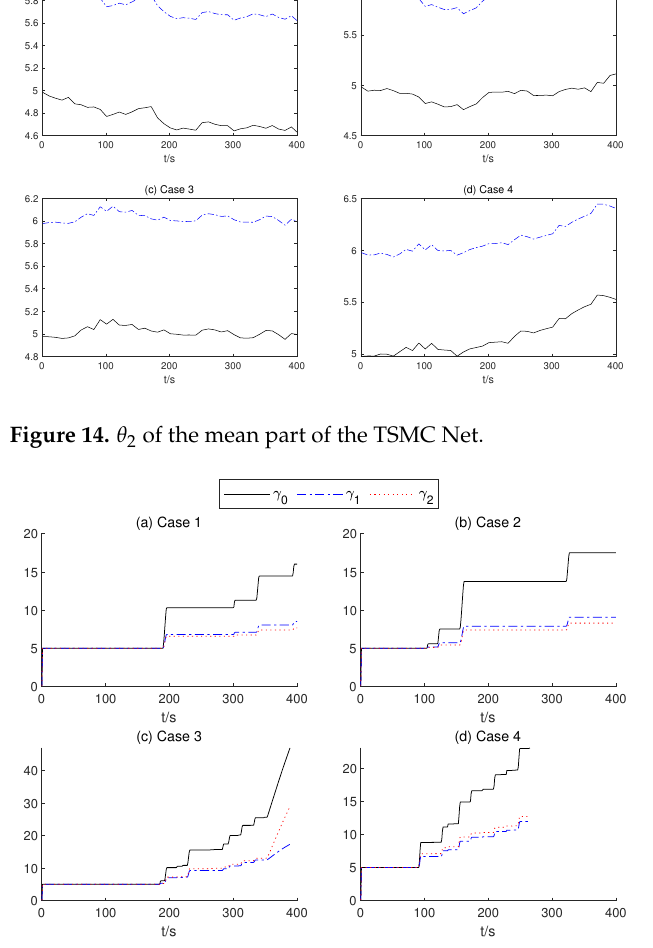
Figure 15. The gain values of the